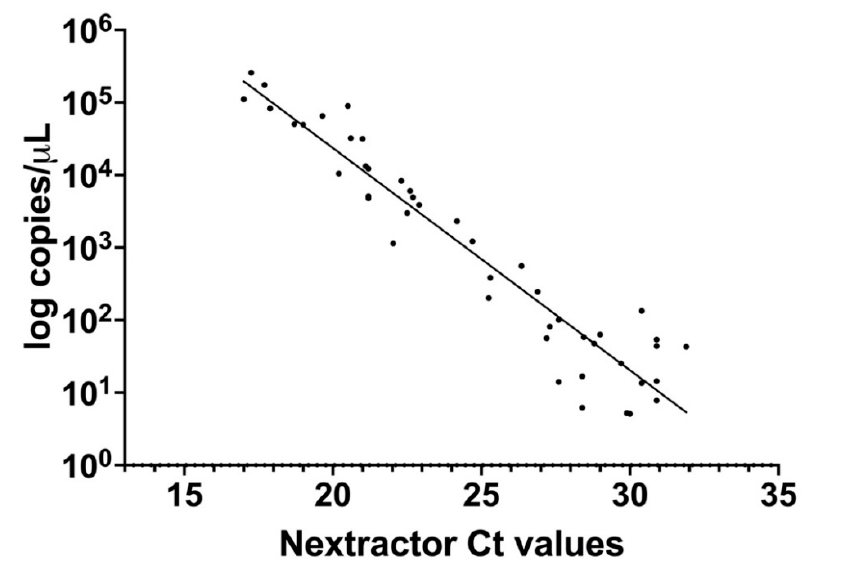
Figure 4. Correlation between the results obtained from the same set of samples by digital polymerase chain reaction (dPCR, number of RNA copies per µL on a log 10 scale) and chain reaction (dPCR, number of RNA copies per µ L on a log 10 scale) and quantitative reverse- quantitative reverse-transcription polymerase chain reaction (qRT-PCR) with preliminary RNA transcription polymerase chain reaction (qRT-PCR) with preliminary RNA extraction (Nextractor extraction (Nextractor Ct values). Ct